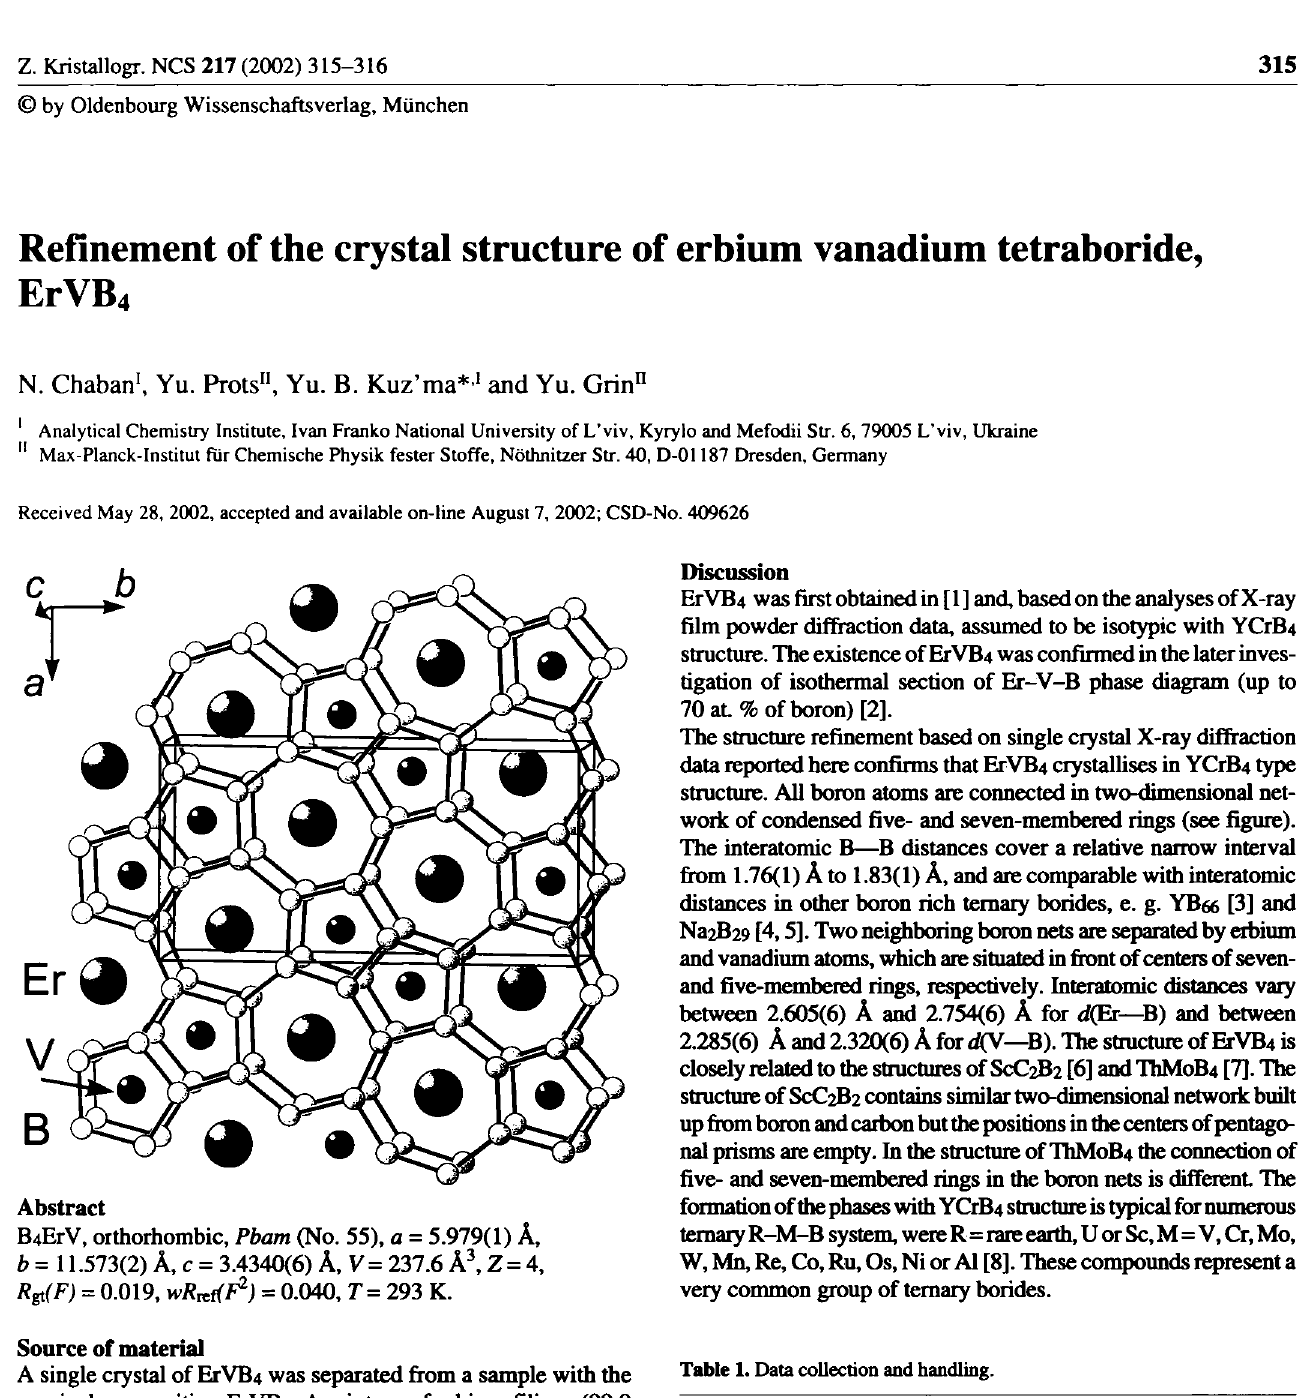
Table 1. Data collection and